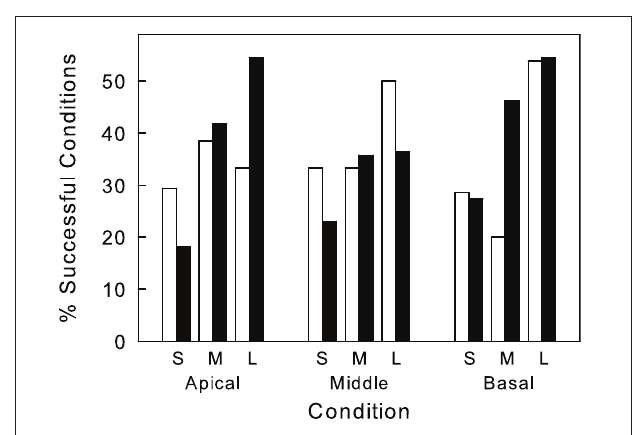
Bilateral tinnitus percepts for subjects S3, S5, S6, and S8 are listed by ear. Symbols at − 100% suppression (complete adaptation) were shifted by up to 5% for visualization purposes. A dotted line is shown at − 30% suppression to indicate the cutoff for successful suppression.